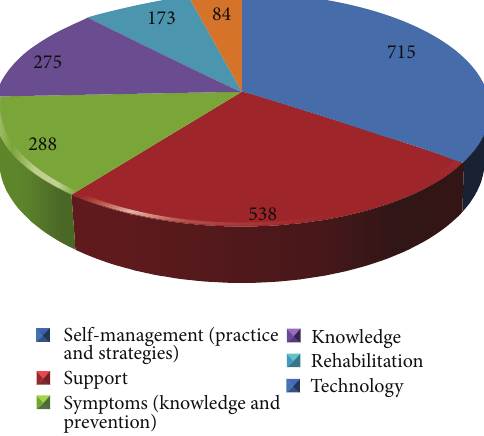
Figure 1: Core themes and reference totals extracted after coding analysis at Phase